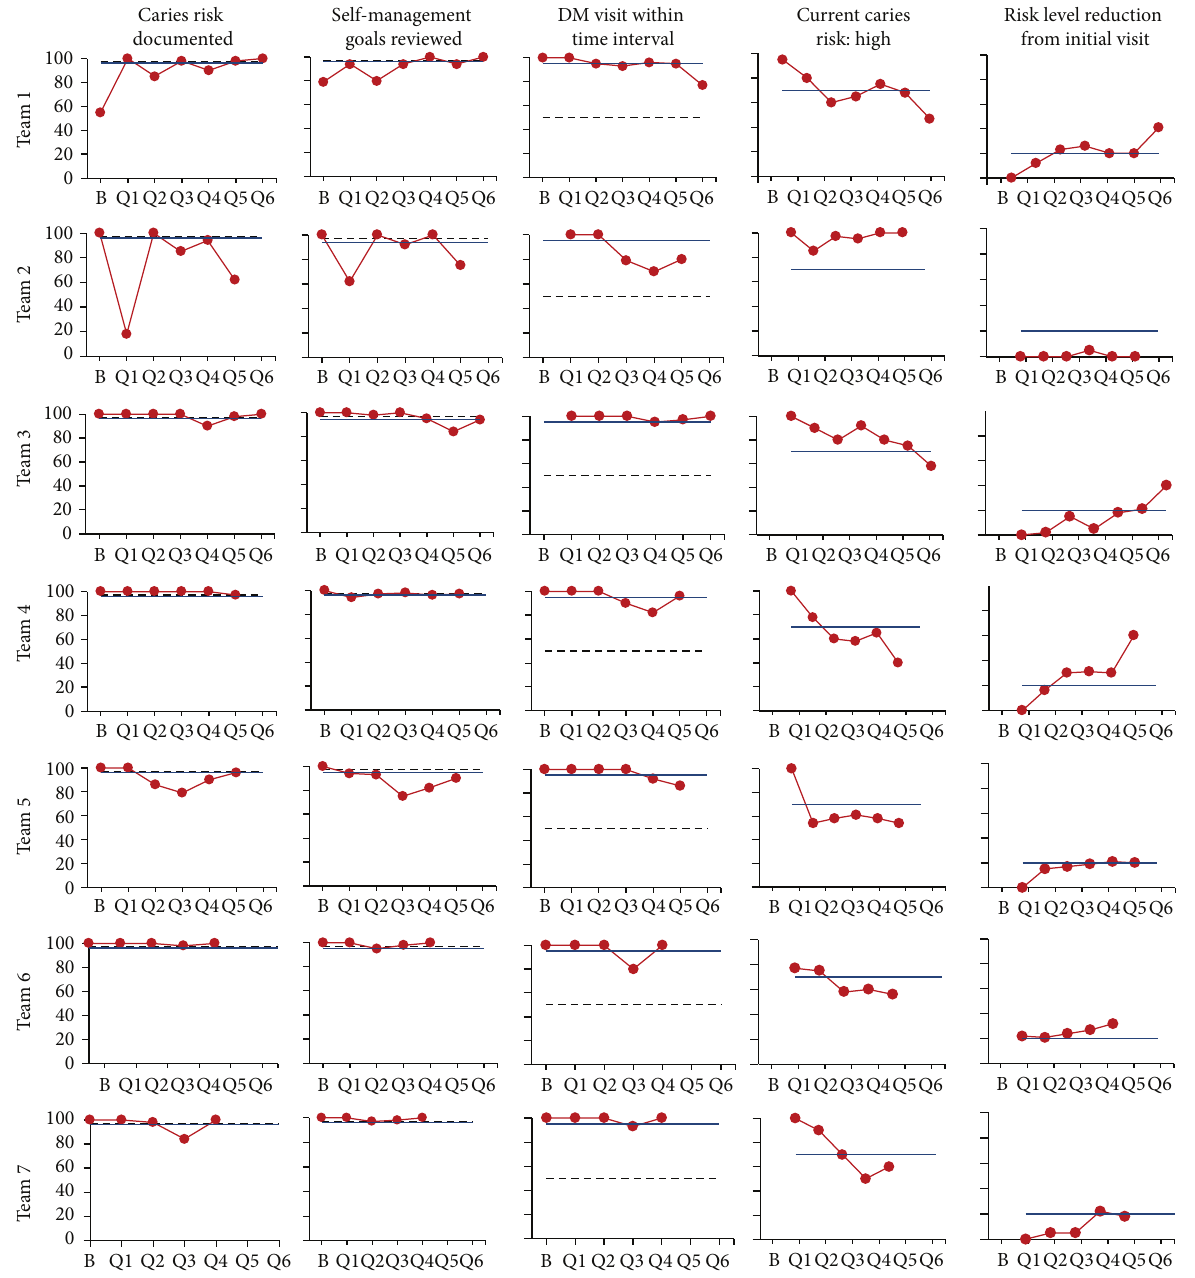
Figure 4: Run charts showing some of the trend data for the ECC Phase 2